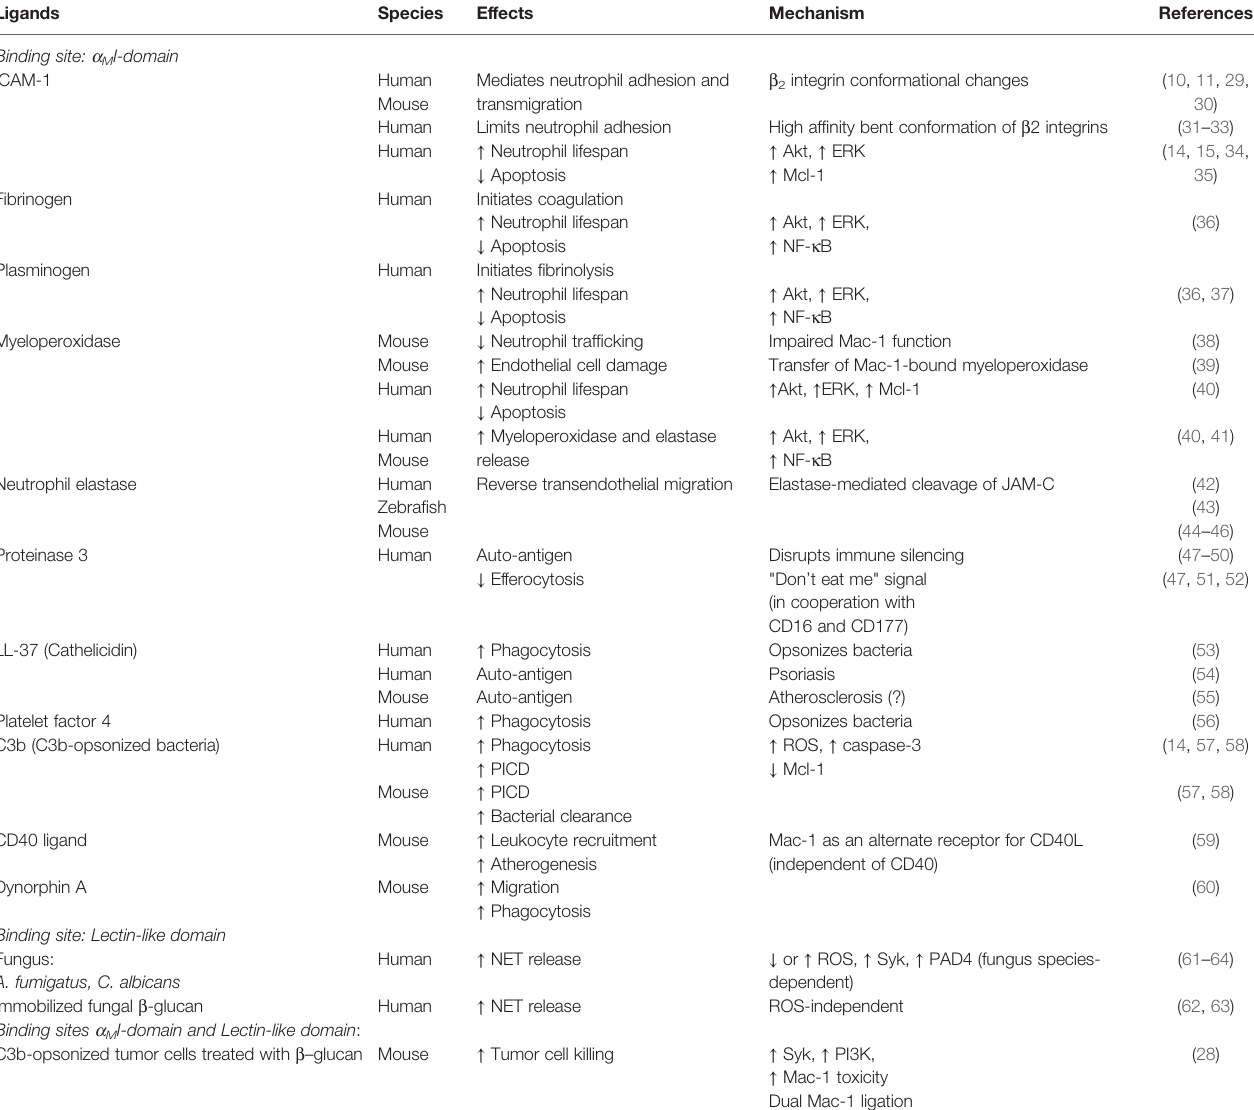
TABLE 1 | Selected Mac-1 (CD11b/CD18) ligands and their